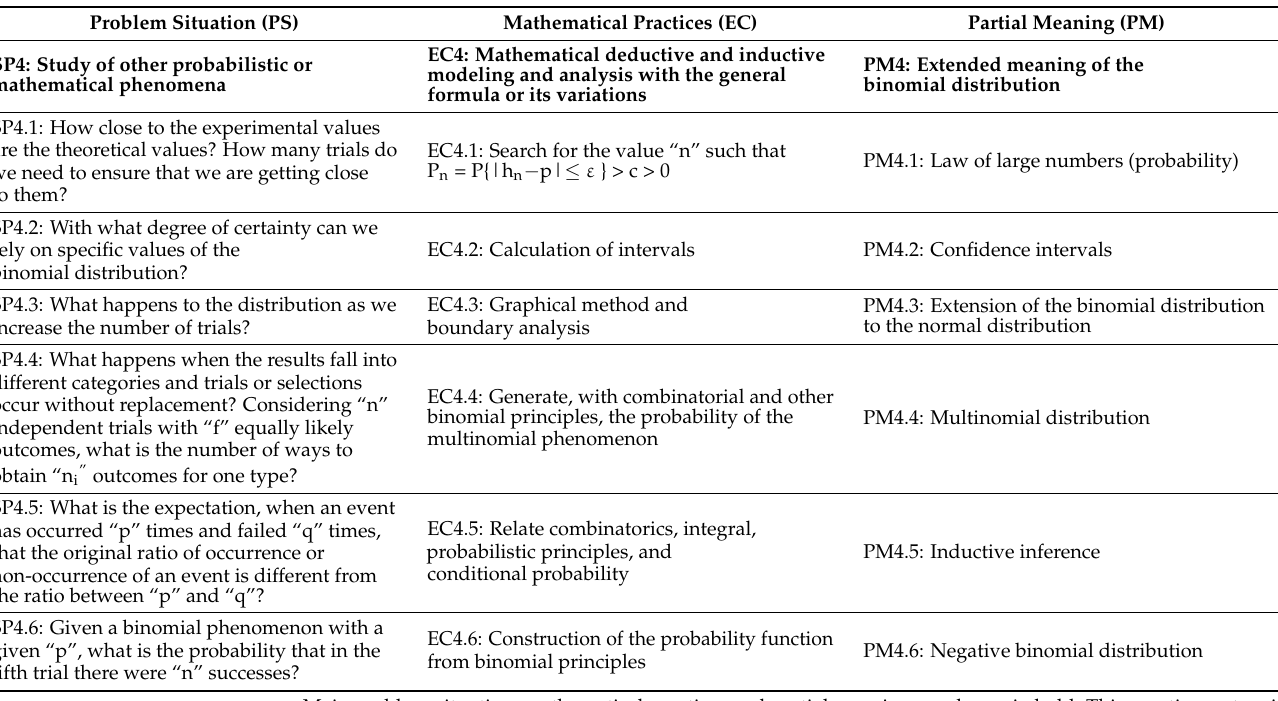
Table 7. Practice system for problems involving the binomial distribution in other areas of probability or